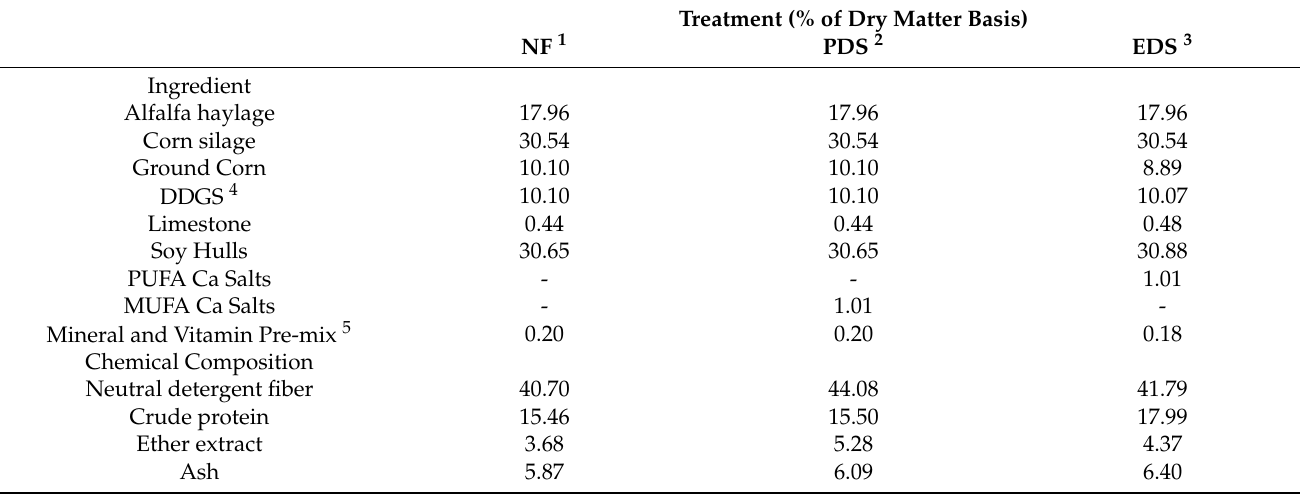
experiment. Feed samples were taken weekly and pooled for further analysis. No orts (feed refusals) were registered during the entire research period for the dams. At birth (day 0), the supplementation stopped and all ewes and lambs were placed in a common pen and feed ad libitum the same diet until weaning (day 60). Measurements of ewe BW and body condition score (BCS) were taken at day -50 and day -9. For the BCS the sample was assessed using a 5-point scale [19]. Blood samples were taken from ewes at lambing (day 0). Table 1. Diet ingredients and chemical composition (% DM basis) of the dietary treatments fed to pregnant ewes at 2.02 kg/day during the last 50 days of gestation.